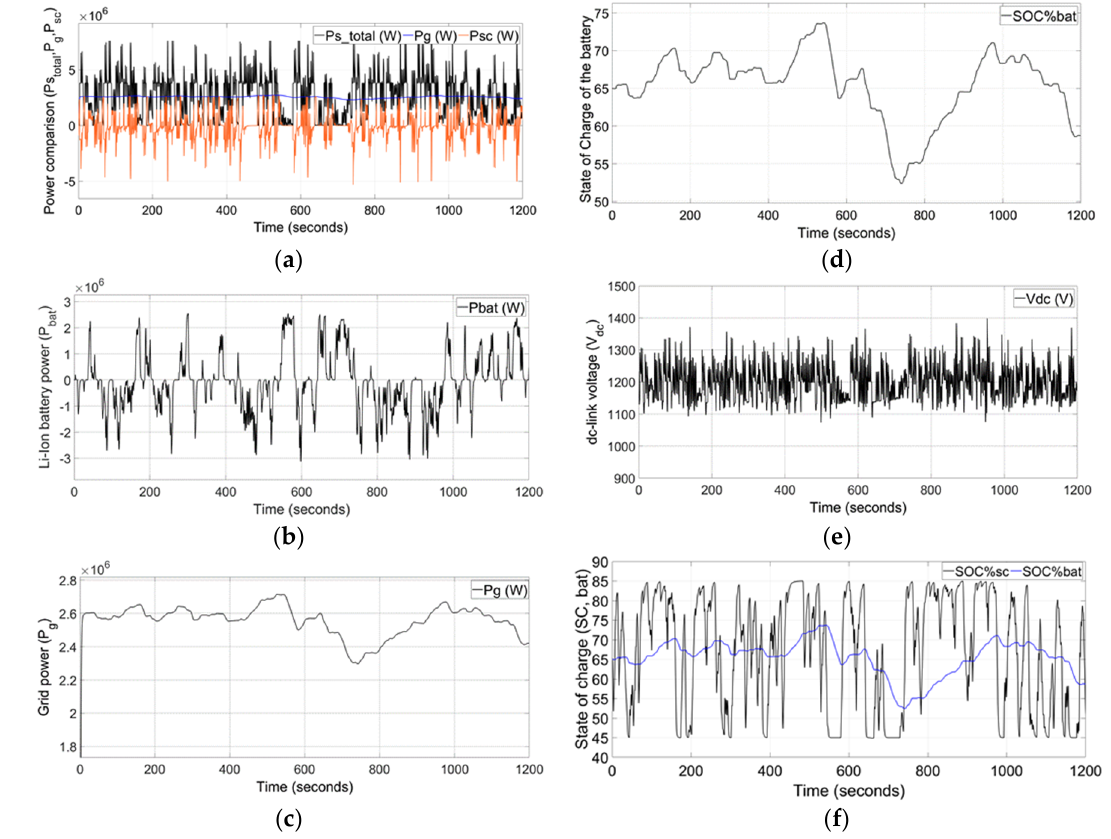
Figure 7. Fourth case study. ( a ) Power comparison of VOWC generators combined power (P in_total ), grid power (P g ), and supercapacitor power (P sc ), ( b ) Li-ion battery power (P bat ), ( c ) grid power (P g ), ( d ) state of charge of the battery (SOC bat ), ( e ) DC-link Voltage (v dc ), ( f ) state of charge of the supercapacitor (SOC sc ) and battery (SOC bat ).